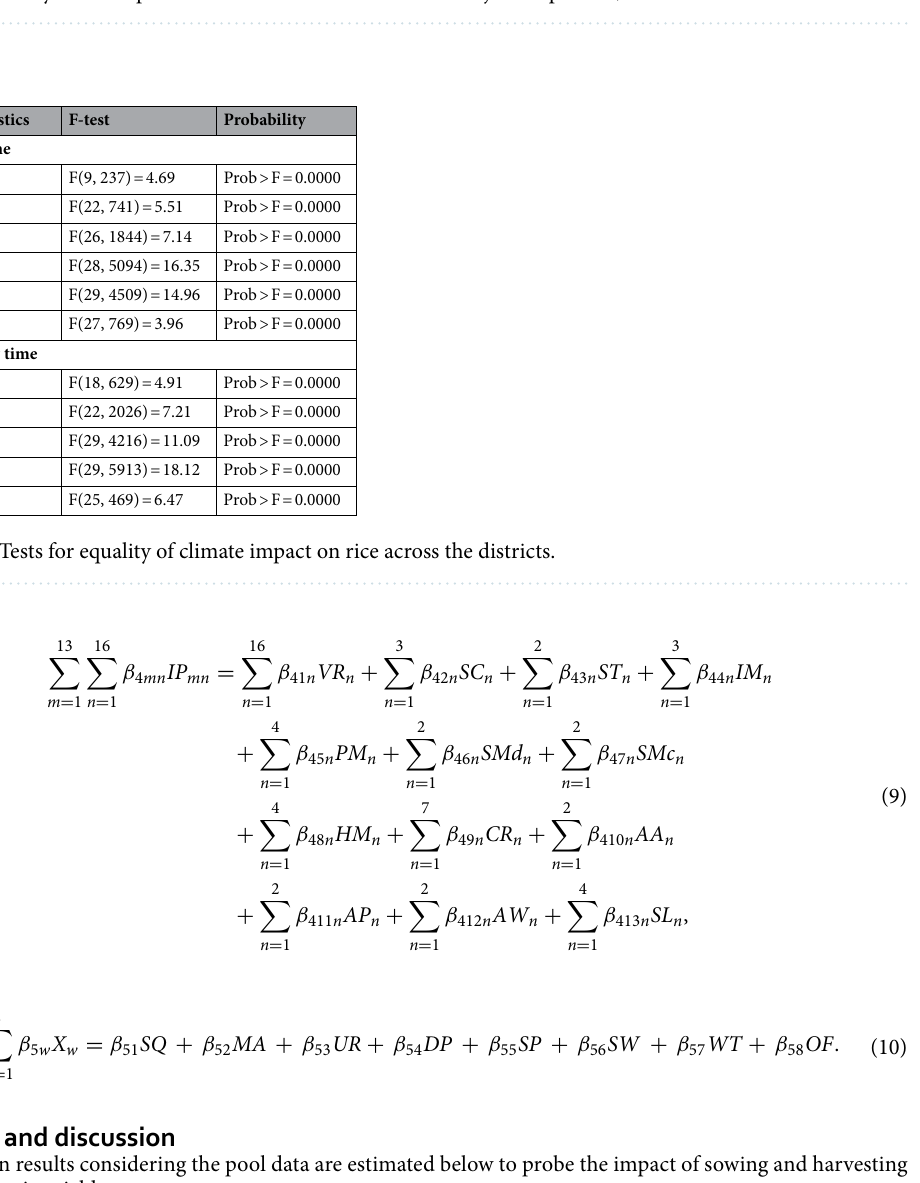
Table 5. Rice yield as dependent variable in districts of the Punjab. ***p < 0.01, Robust standard errors.